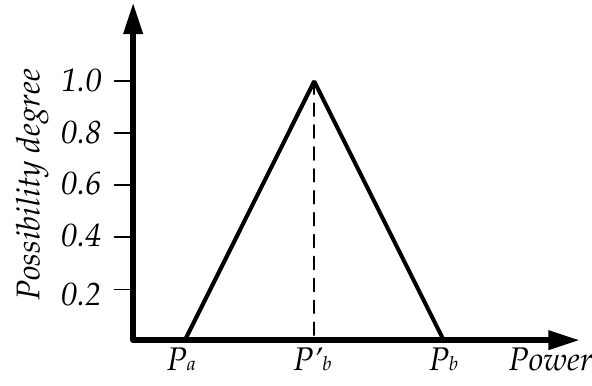
Figure 2. Example of fuzzy set representation.